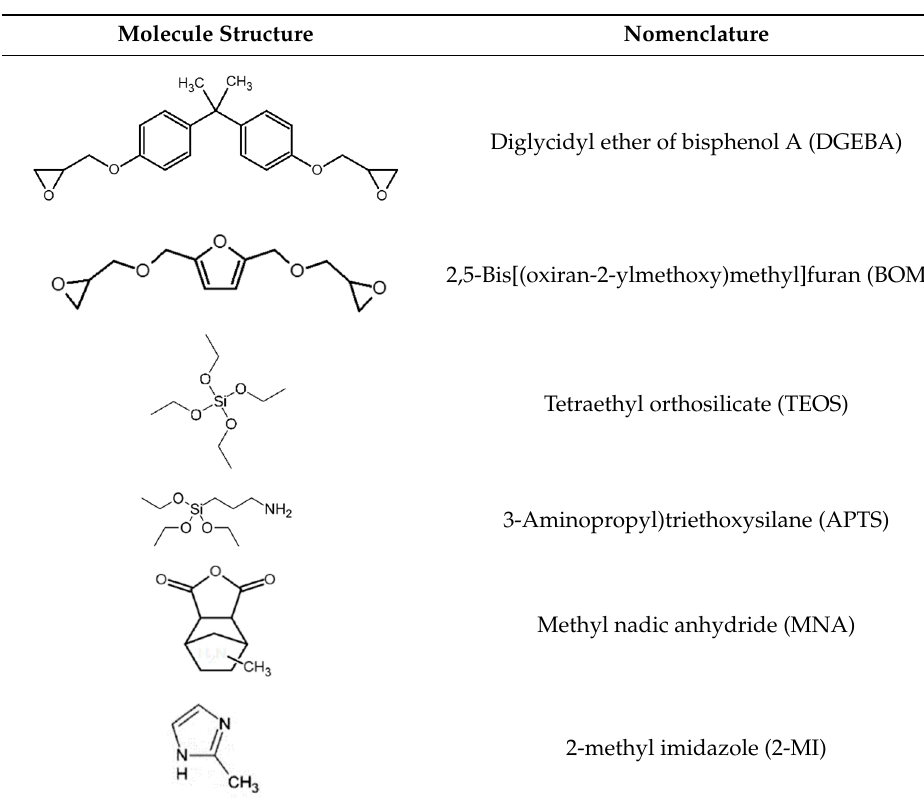
Table 1. Chemical structure and related nomenclature of the products used for the synthesis of epoxy systems and of the corresponding hybrids.